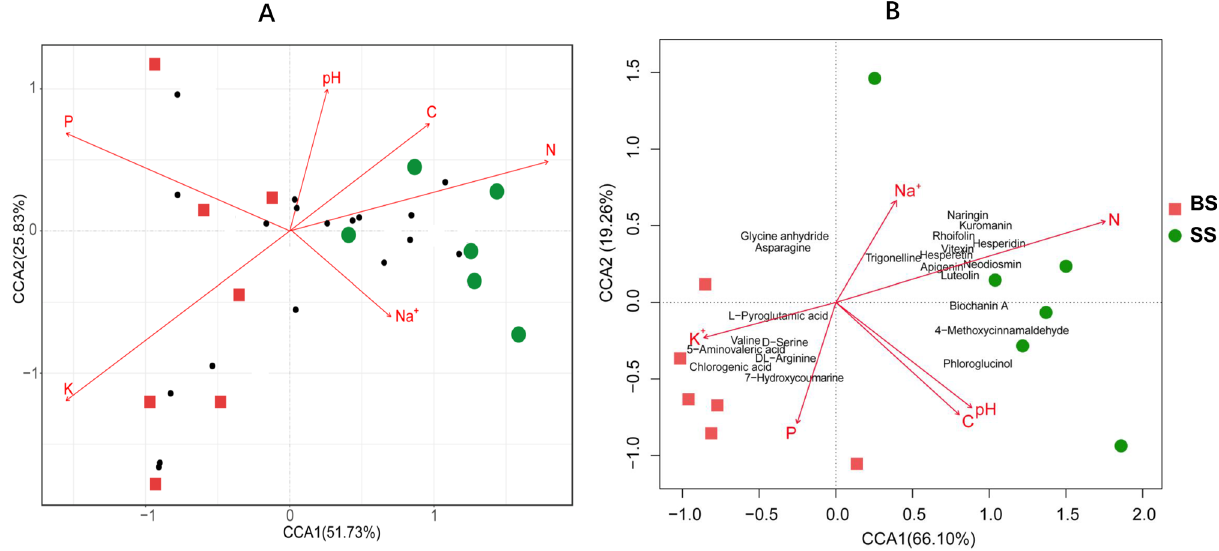
Figure 4. CCA analysis of soil properties correlated with the soil microbial communities and metabolites of sugarcane. ( A ) Correlation between the content of soil properties and the relative abundance of the top 18 soil differential microbes at the genera level (black dot corresponds to a bacterial genus). ( B ) Correlation between the content of soil properties and 22 distinct metabolites of sugarcane stalk. Vectors show the relationship between the secondary variables and the microbial community data, where the length and angle are determined by the correlation of each variable with the ordination axes. ‘pH’, ‘C’, ‘N’, ‘P’, ‘K’, and ‘Na’ refer to soil properties. Figures were produced using R (v3.4.3, https ://www.R-proje ct.org).